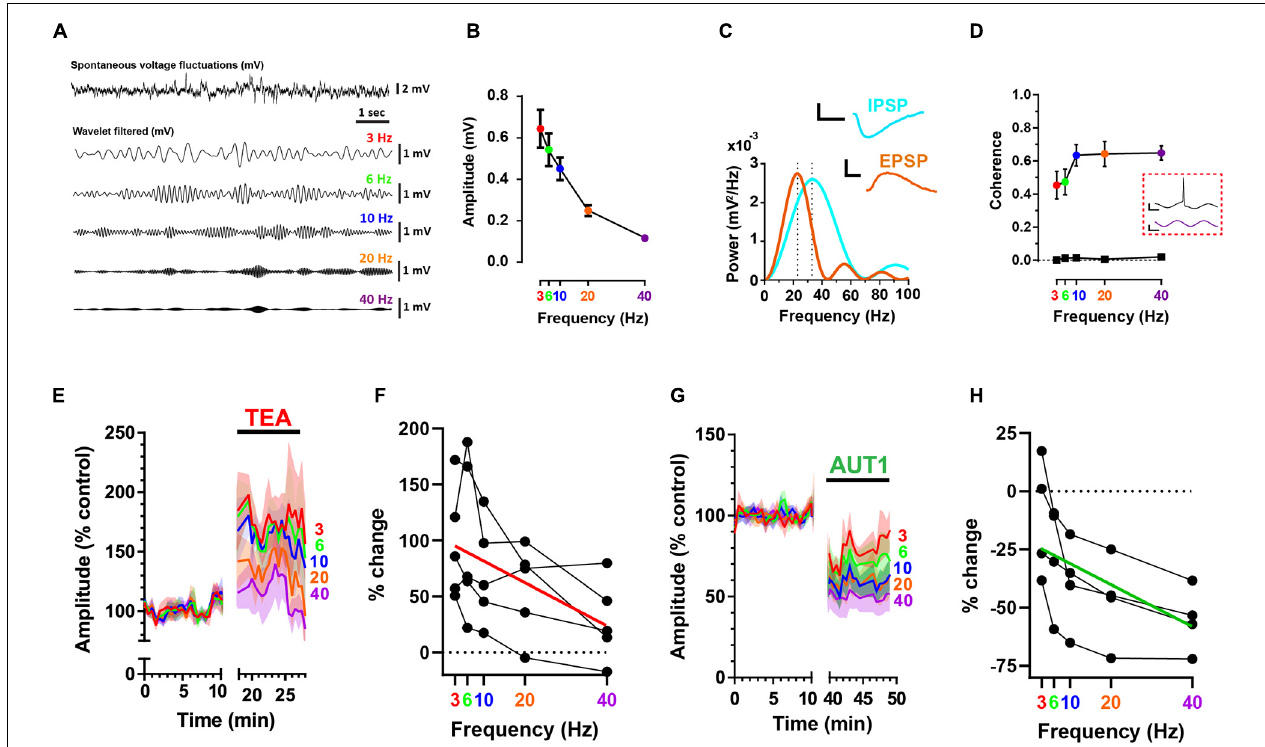
FIGURE 2 | Positive modulation of Kv3 K + currents reduces high frequency voltage fluctuations at the fusiform cell membrane. (A) Whole-cell current clamp recordings showing a portion of spontaneous voltage fluctuations (top trace) recorded from a fusiform cell filtered using cosine wavelets (lower traces) centered at 3 (red), 6 (green), 10 (blue), 20 (orange), and 40 Hz (purple). (B) Peak-to-peak wavelet-filtered voltage amplitude as a function of wavelet center frequency ( n = 9). Error bars = SEM. (C) Power spectra (mV 2 /Hz) for the mean excitatory (EPSP, brown) and inhibitory (IPSP, cyan) spontaneous post-synaptic potentials ( n = 9). Spontaneous EPSPs and IPSPs are represented as Gaussian functions with frequency domains centered at 23 and 33 Hz, respectively (illustrated by the vertical dashed lines). The mean sEPSP and sIPSP are shown in the inset. Horizontal scale bars: 10 ms; vertical scale bars: 1 mV. (D) Coherence between action potential firing and wavelet-filtered noise stimuli as a function of wavelet center frequency ( n = 7). Bottom trace (black squares) depicts the coherence for identical spike trains but measured in relation to newly generated wavelet-filtered noise stimuli (i.e., not used in the experiments). Data show the mean (error bars = SD) from 100 wavelet stimuli at each frequency. Inset (red dashed box): action potential (top) elicited in response to a portion of wavelet-filtered noise centered at 40 Hz (bottom). Horizontal scale bars: 10 ms; upper and lower vertical scale bars: 20 mV and 300 pA, respectively. (E,G) Peak-to-peak subthreshold membrane voltage fluctuation amplitudes were recorded in the control condition and following the perfusion of 0.5 mM TEA (E) or 30 µ M AUT1 (G) . Shaded error bars = SEM. (F,H) Percent change (relative to control) of subthreshold voltage fluctuation amplitudes as a function of frequency, for amplitudes measured in presence of TEA ( F , n = 5) and AUT1 ( H , n = 5). Red (F) and green (H) lines represent linear fits to the data. (A–H) Holding potential: –65 mV.